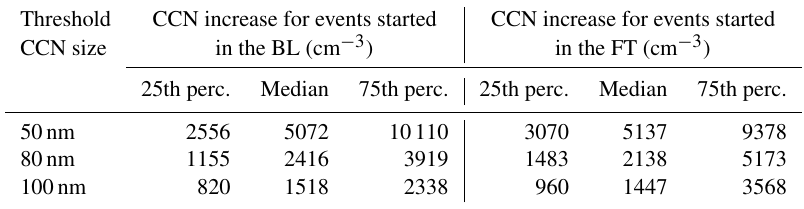
Table 4. CCN production as a function of the location of the station (BL or FT) at the onset of the NPF process. Threshold CCN increase for events started CCN increase for events started CCN size in the BL (cm − 3 ) in the FT (cm − 3 ) 25th perc. Median 75th perc. 25th perc. Median 75th perc. 50nm 2556 5072 10110